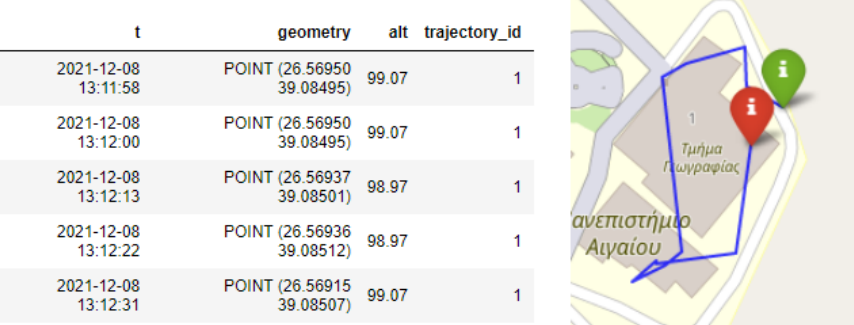
Figure 8. A trajectory reconstructed from extracted data/metadata.